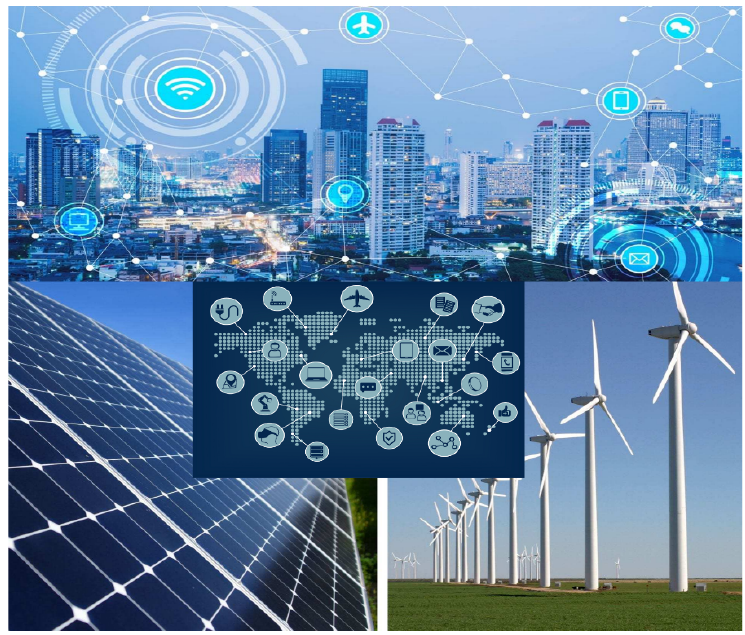
Figure 2. Energy harvesting in a smart